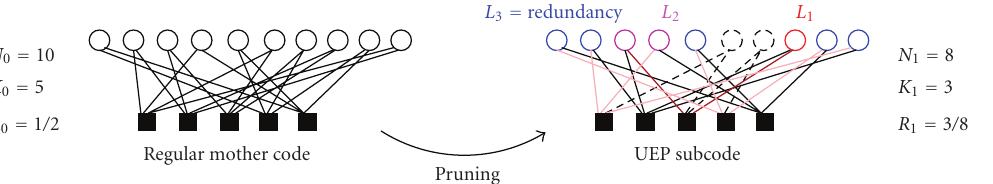
Figure 10: Pruning in the Tanner graph to exhibit UEP